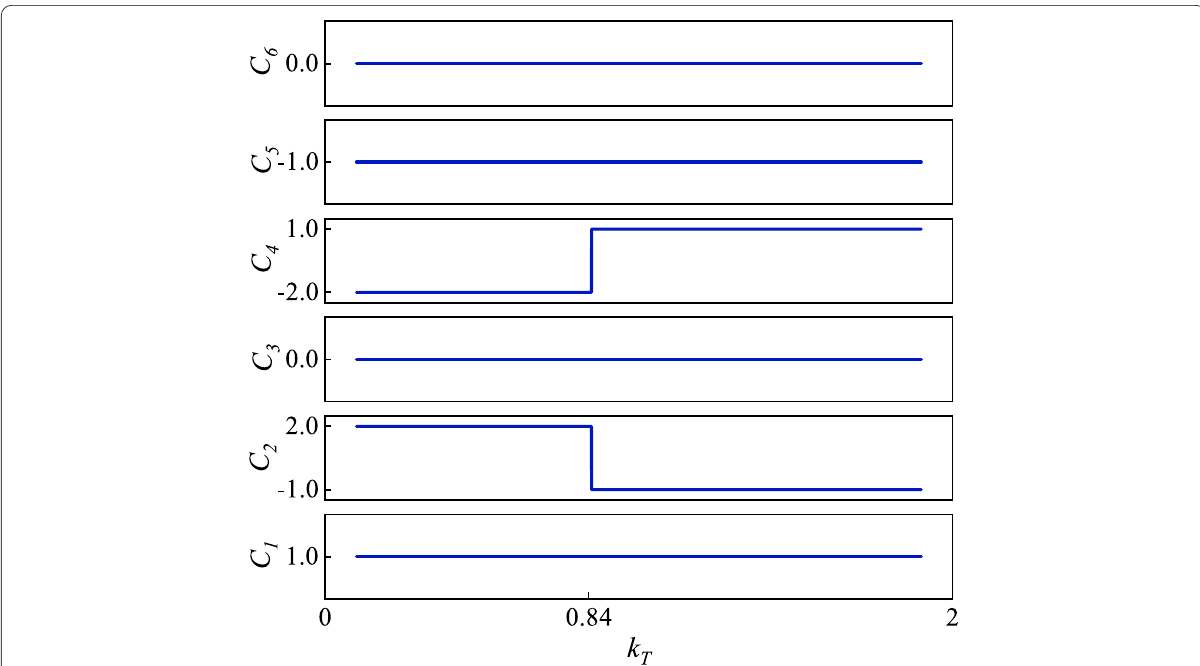
1,2,3,4,5,6). Taking r = 2 as an =